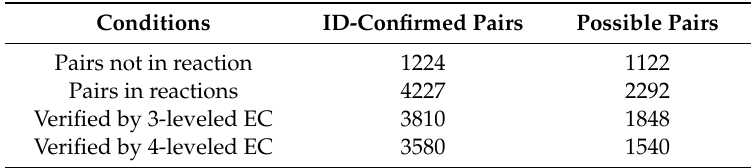
Table 7. Correspondences between KEGG and MetaCyc compounds verified by